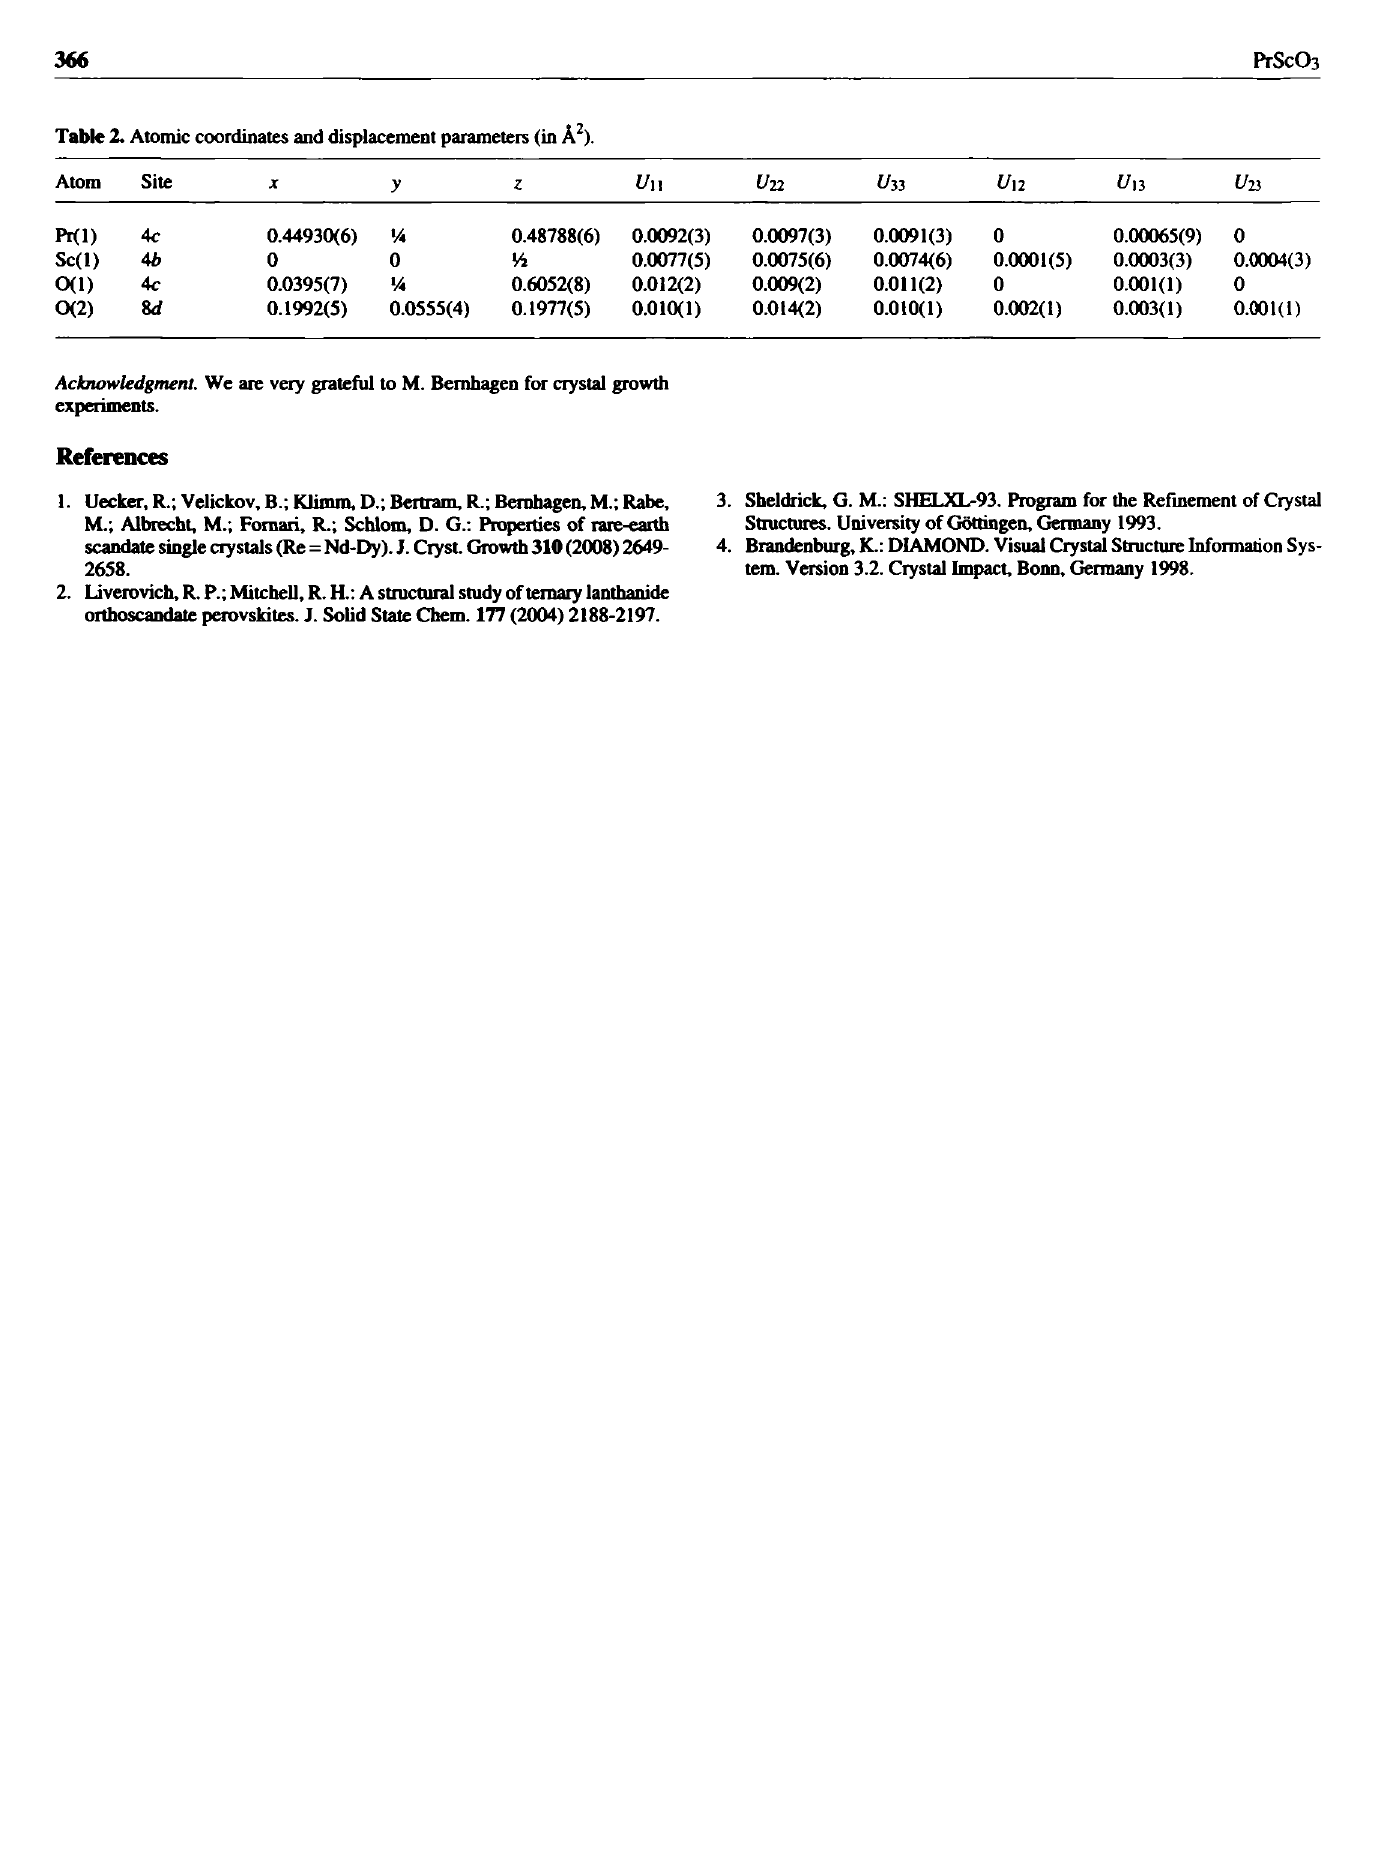
Table 2. Atomic coordinates and displacement parameters (in Á 2